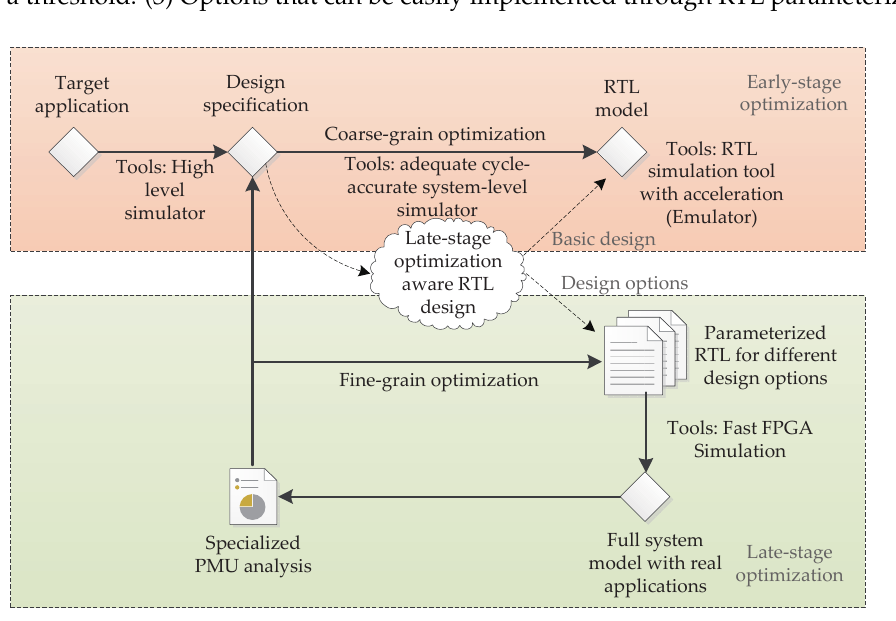
Figure 2. The FPGA-enhance design flow for processor